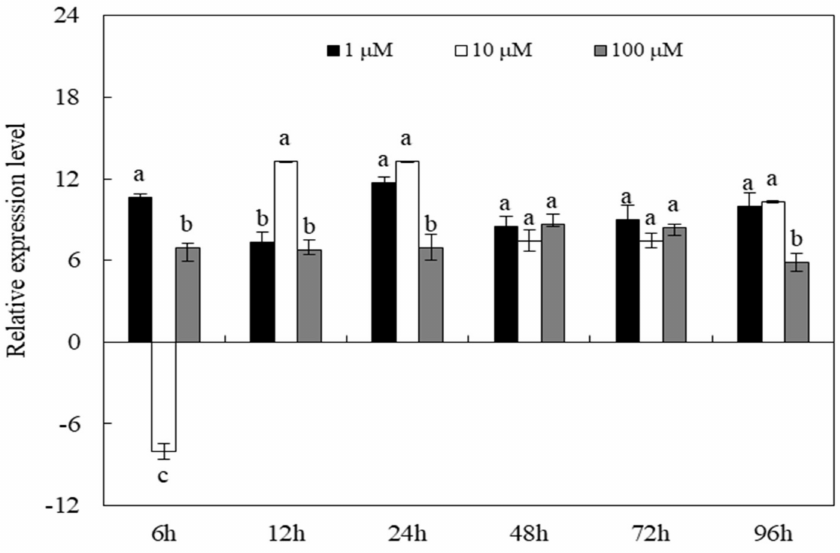
Figure 3. Transcriptional profiles of CYP6EV11 in the 4th instar C. kiiensis larvae following exposure to three doses of phenol (1, 10 and 100 µ M) during a 96-h period. The larvae without phenol treatment were regarded as controls. The standard error (SE) bars were calculated based on three experimental replicates. The bars with different letters (a–c) are significantly different at p < 0.05 based on one-way ANOVA followed by Duncan multiple comparisons. All of the relative expression levels were log2